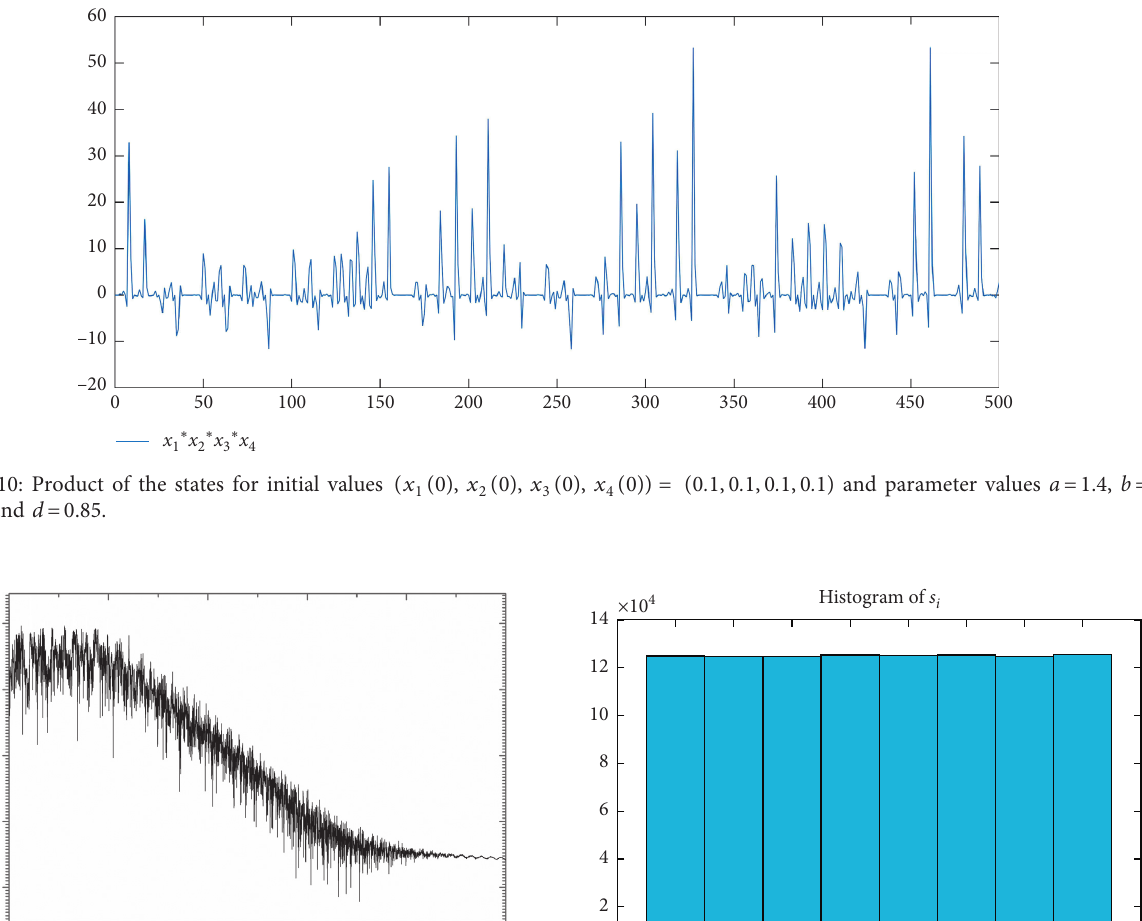
Figure 9: States of the chaotic system for initial values ( x c � 1.4, and d � 0.85.